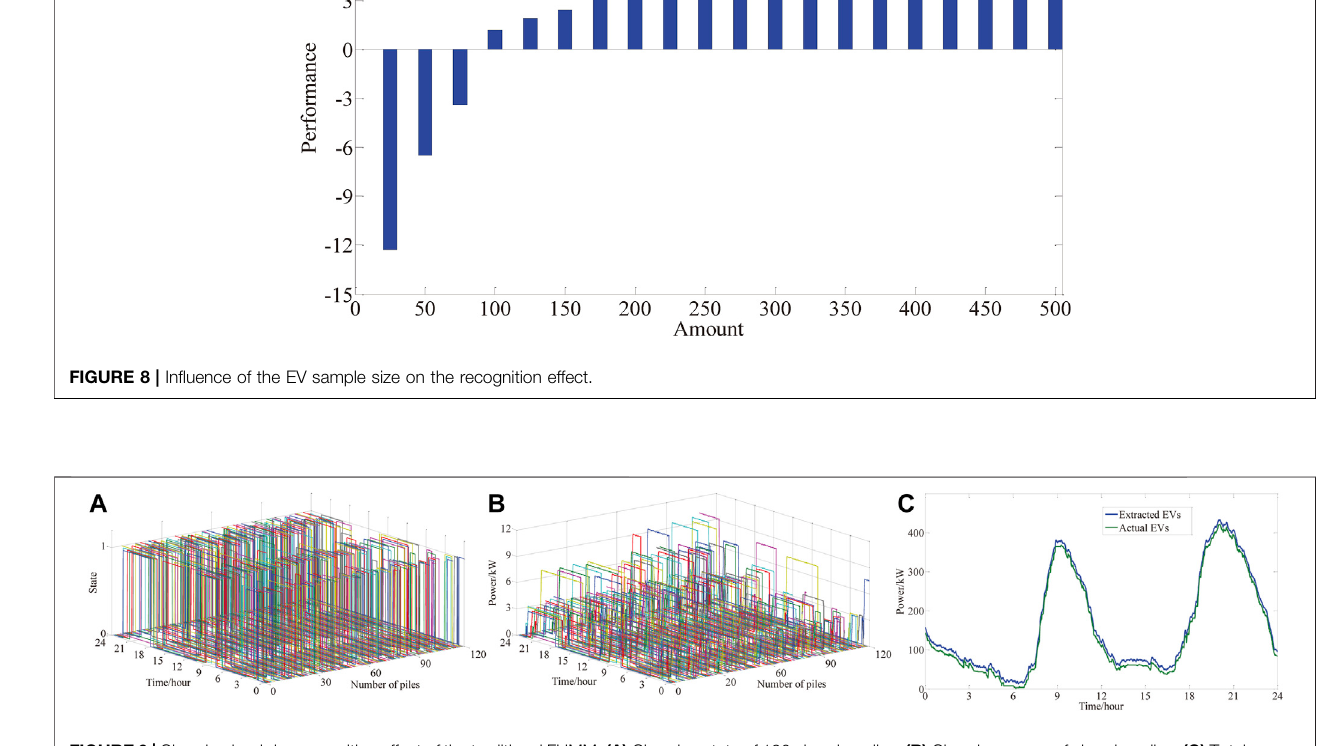
Frontiers in Energy Research |